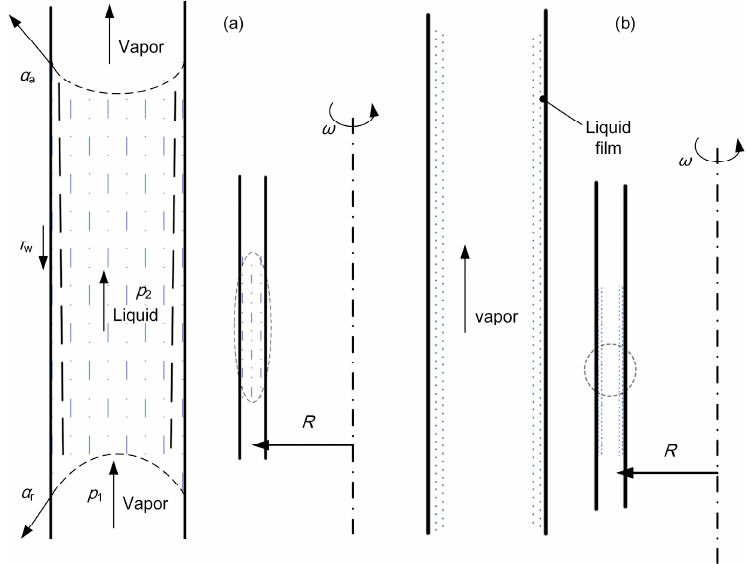
Figure 5. Illustration of liquid slug moving in the OHP: ( a ) right before the vapor penetrating through the liquid slug; and ( b ) right after the penetration of vapor through the liquid slug.